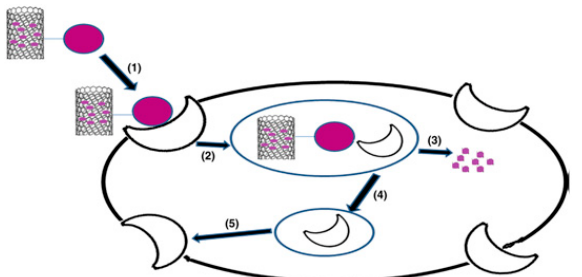
Figure 3. Receptor-mediated endocytosis of CNTs. ( 1 ) Association of ligand conjugated drug-loaded CNTs with receptor; ( 2 ) endosomal internalization of conjugates, ( 3 ) drug release, and ( 4 , 5 ) receptor regeneration [28]. Reproduced with copyright permission from Elsevier, 2016.